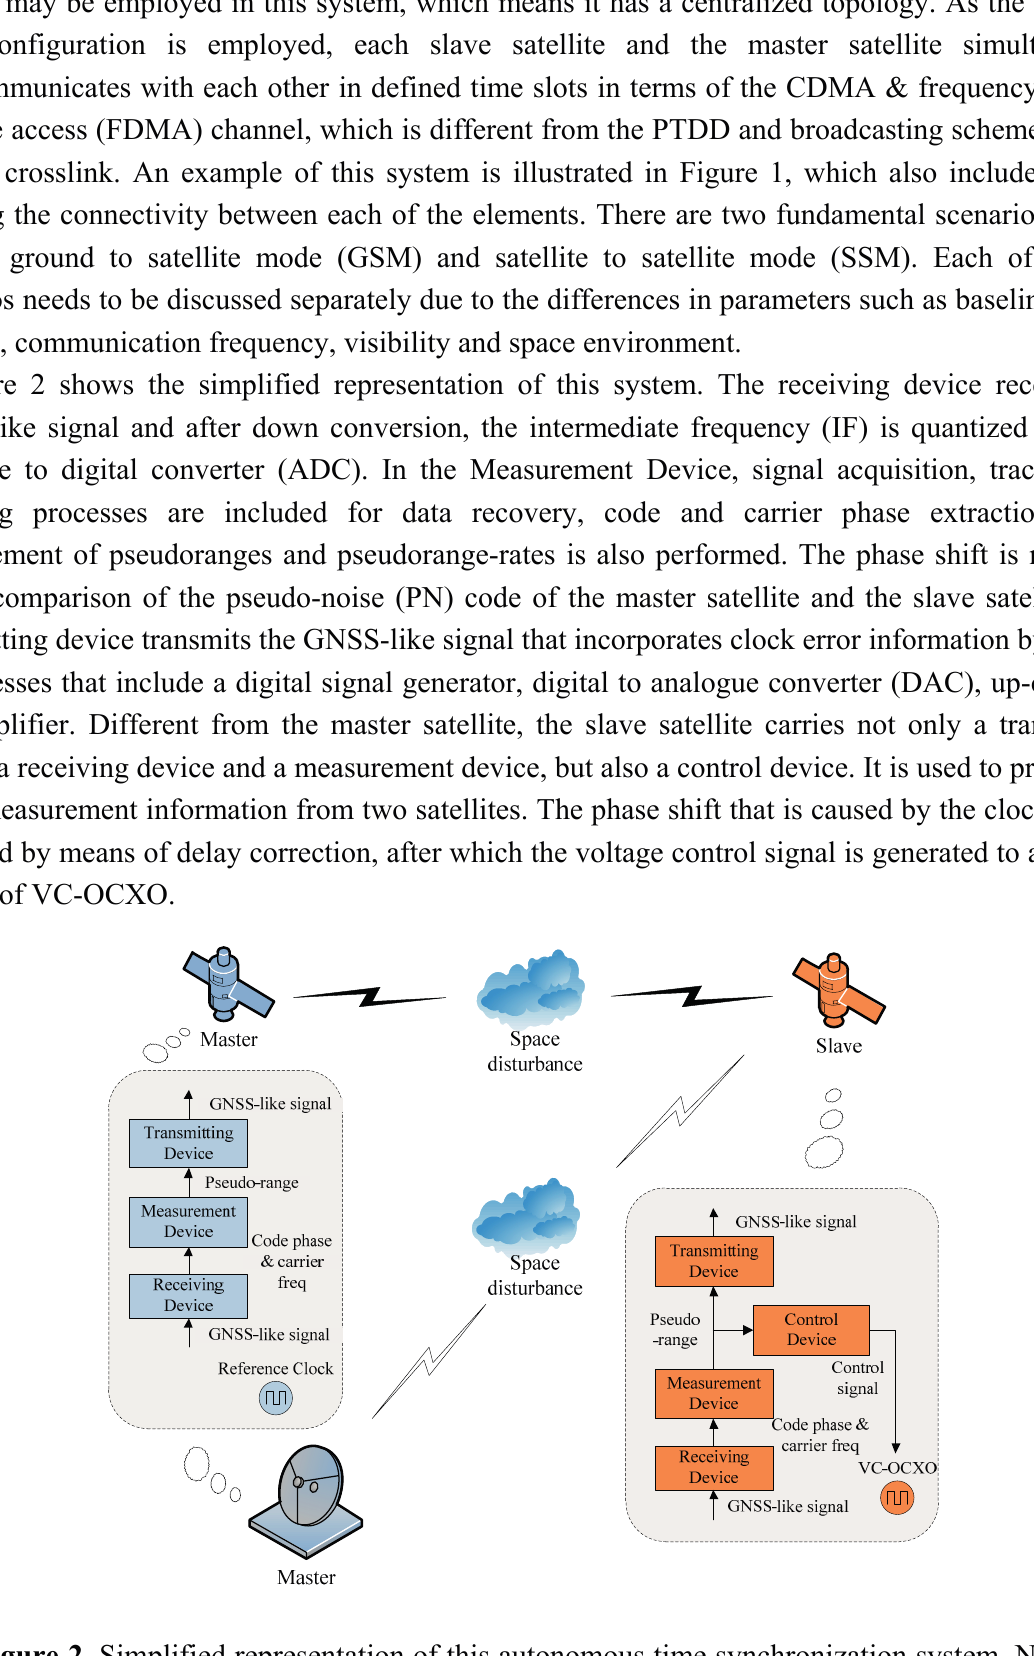
Figure 2. Simplified representation of this autonomous time synchronization system. Note that only one master is present, although this may be space or ground